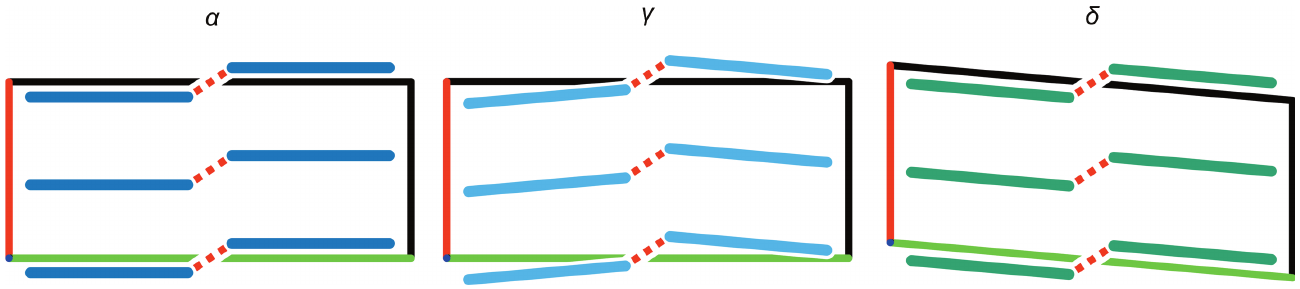
Figure 9 Schematic representation of crystal packing variations observed in 2 (cid:2) AP polymorphs as seen from z . Applied pressure gradually tilts individual stacks, leading to either orthorhombic (cid:3) or monoclinic (cid:4)